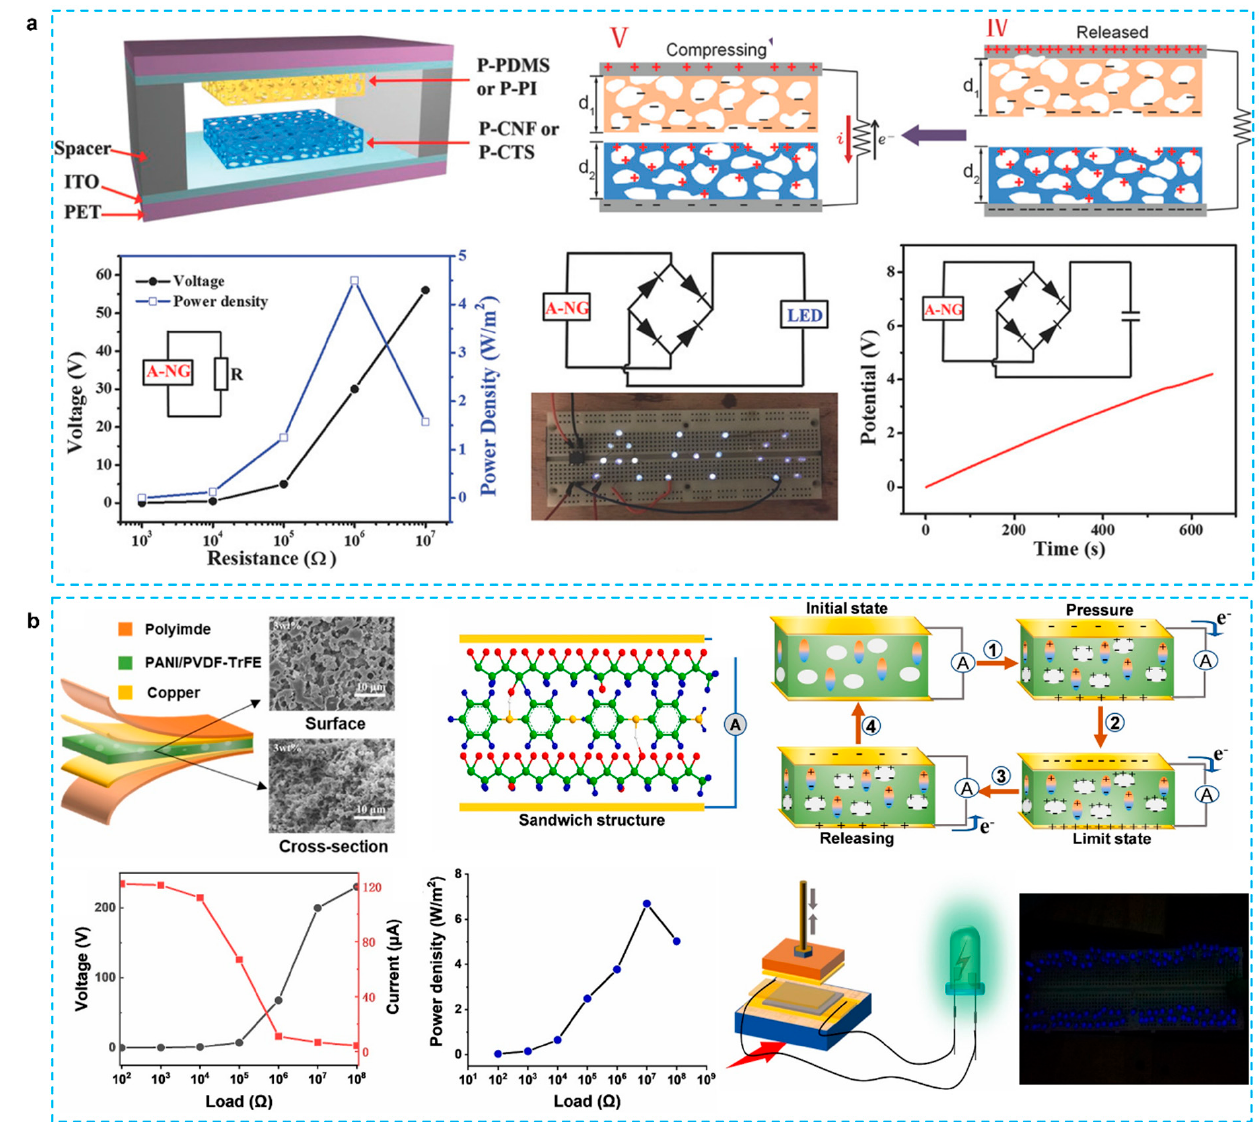
Figure 11. ( a ) Highly porous cellulose nanofibril and Chitosan aerogel based triboelectric nanogenerators [128]. ( b ) PANI/PVDF-TrFE porous aerogel bulk piezoelectric and triboelectric hybrid nanogenerator based on in-situ doping and liquid nitrogen quenching [60].